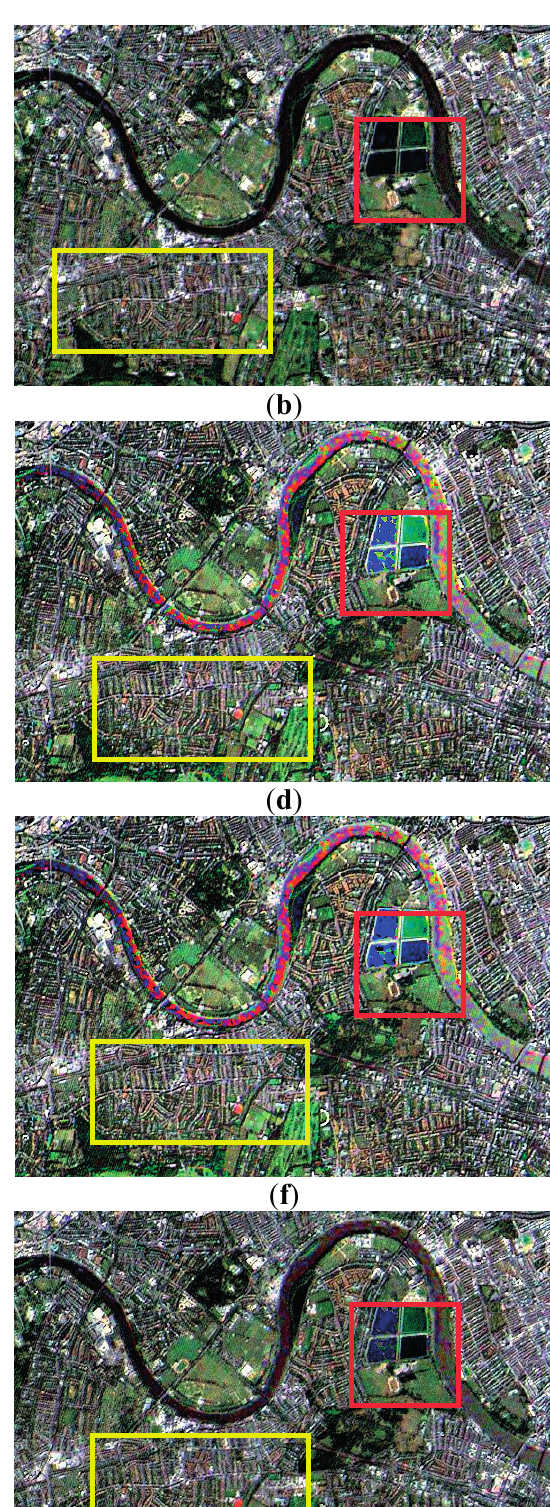
Figure 8. ( a ) Original multispectral image. ( b ) The new BEMD fused image. ( c ) Wavelet fused image (“db10”, 2 levels). ( d ) IHS fused image. ( e ) PCA fused image. ( f ) Brovey fused image. ( g ) Gaussian high-pass spatial filter fused image. ( h ) Laplacian pyramidal decomposition